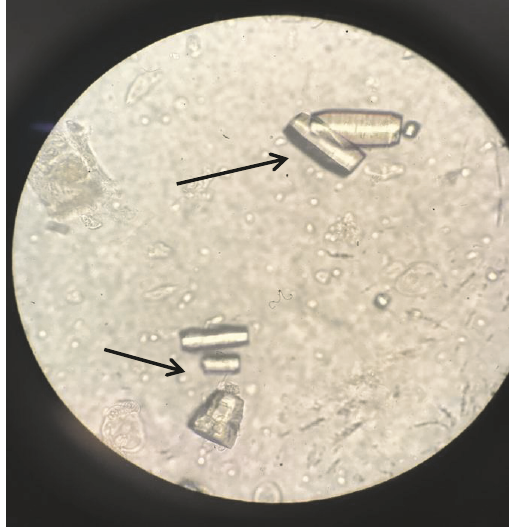
Figure 2: Barrel shaped uric acid crystals under high power magnification.